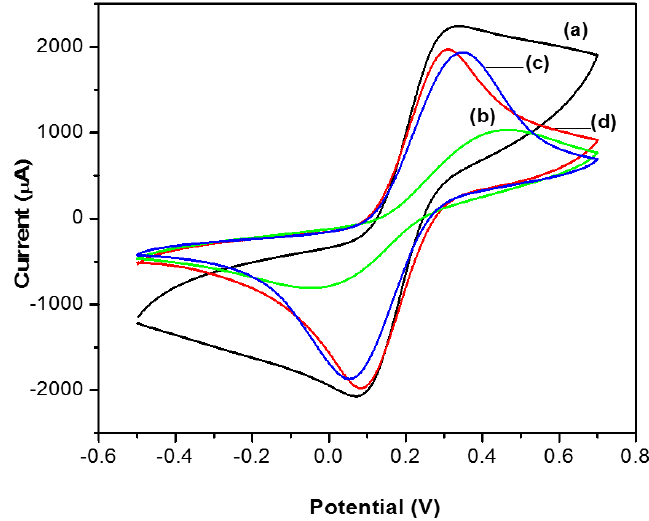
Figure 3. CVs of: ( a ) graphite (GE); ( b ) biosensor NAF/LAC; ( c ) biosensor TiO 2 /LAC; and ( d ) biosensor TiO 2 /NAF/LAC in 0.1 M KCl solution containing 1 mM K 3 Fe(CN) 6 /K 4 Fe(CN) 6 (1:1), at a scan rate of 100 mV/s.